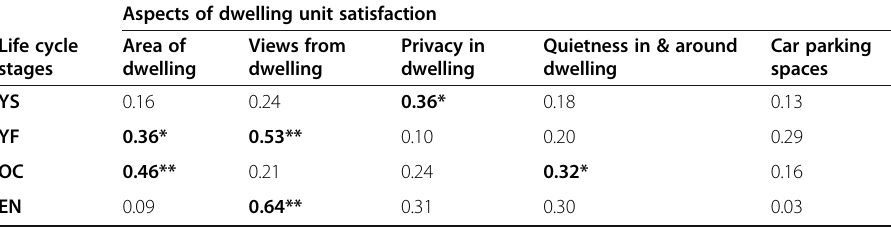
Table 5 Correlations between dwelling unit satisfaction and its different aspects Aspects of dwelling unit satisfaction